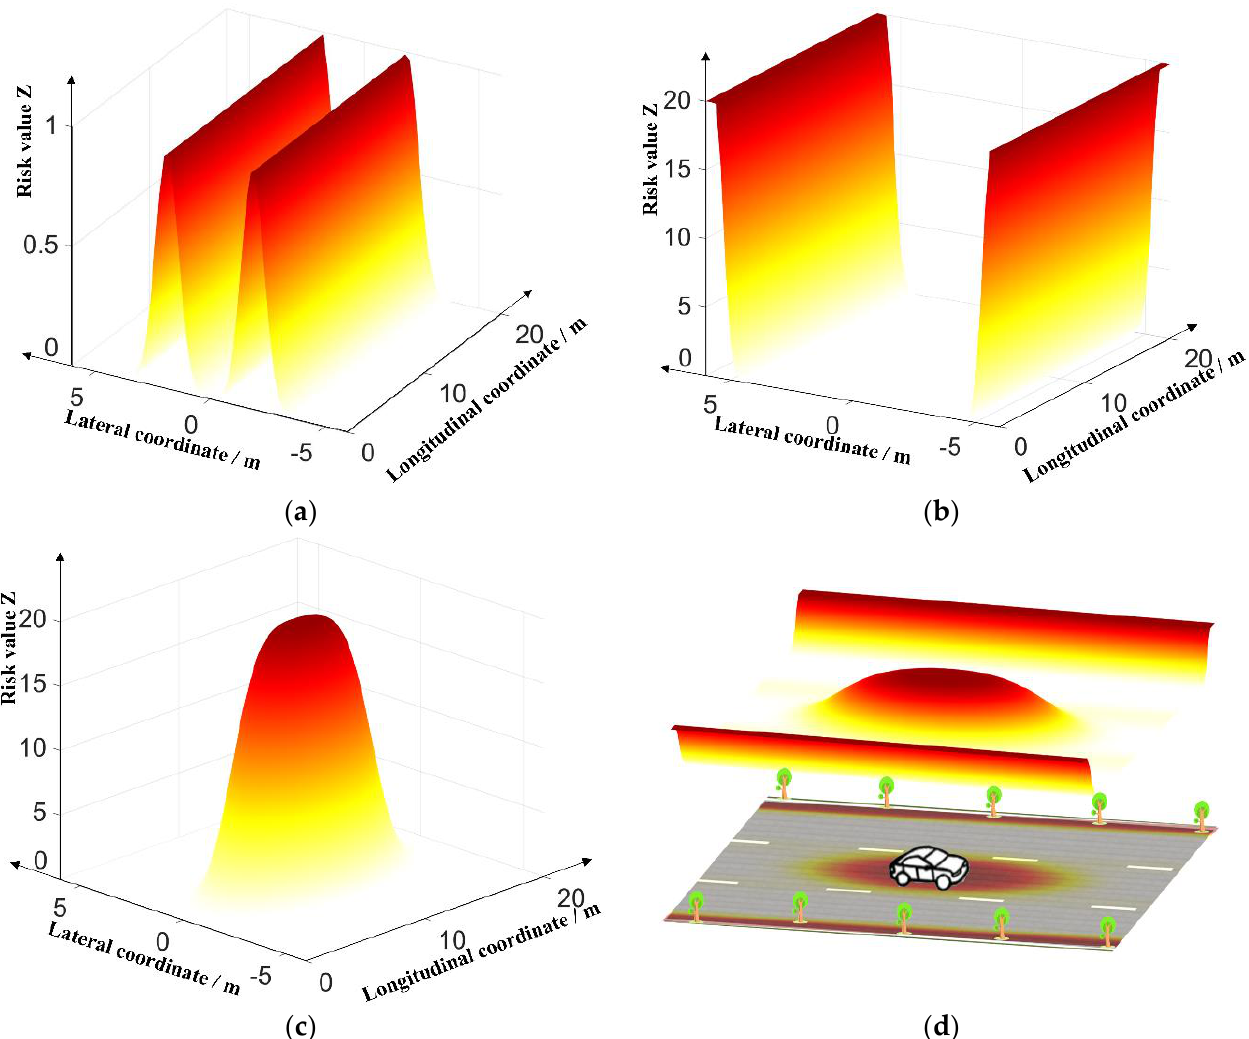
Figure 1. Risk-field distribution of risk sources in traffic environment: ( a ) road divider risk-field; ( b ) road boundary risk-field; ( c ) obstacle vehicle risk-field; ( d ) total risk-field.